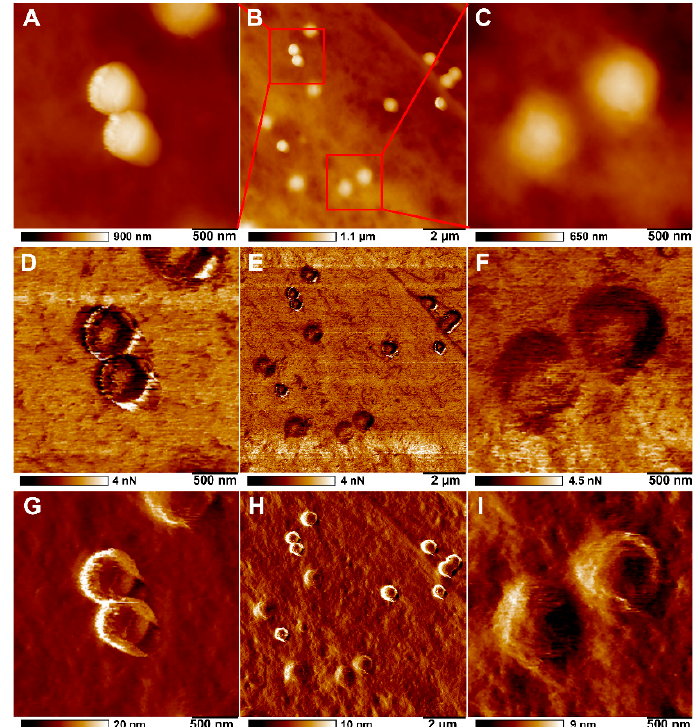
Figure 7. AFM images of topography ( A – C ), adhesion ( D – F ) and deformation ( G – I ) showing the distribution of 500 nm polystyrene particles in HSF after 24 h co-incubation. ( B , E , H ) The region of cell with polystyrene particles ( A , D , G ) on the surface and ( C , F , I ) inside the cell. Table 1. Nanomechanical parameters (adhesion, DMT modulus, and deformation) of HSF surface and 500 nm polystyrene outside and inside cells.